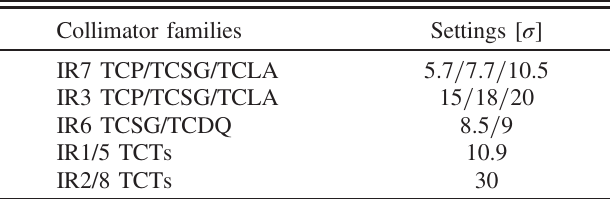
TABLE I. Collimator retraction settings used in SIXTRACK simulation at 7 TeV. The values are expressed in units of standard deviation of the beam, calculated for a normalized emittance of 3 . 5 μ m rad. Note that in the table the design settings for TCTs in IP1 and IP5 are listed. In simulations, a scan over a wide range of values has been performed.